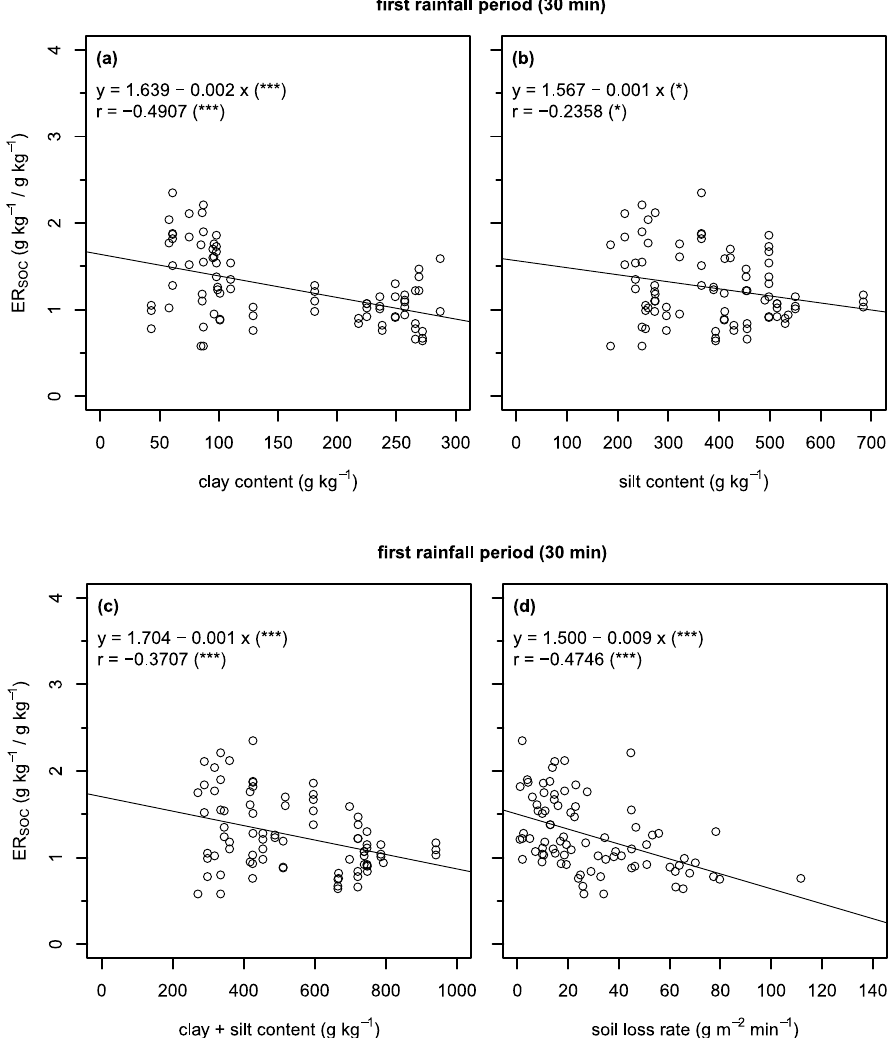
Figure 6. Simple linear regression of the soil organic carbon enrichment ratio (ER SOC ) in the first rainfall period (30 min) against ( a ) the clay content, ( b ) silt content, ( c ) clay + silt content, and ( d ) soil loss rate. The regression functions and Pearson product–moment correlation coefficients ( r ) are given for each parameter fitting. The significance levels of the regression function slopes and r , indicating a difference from zero, are as follows: (***) p < 0.001; (*) p < 0.05.